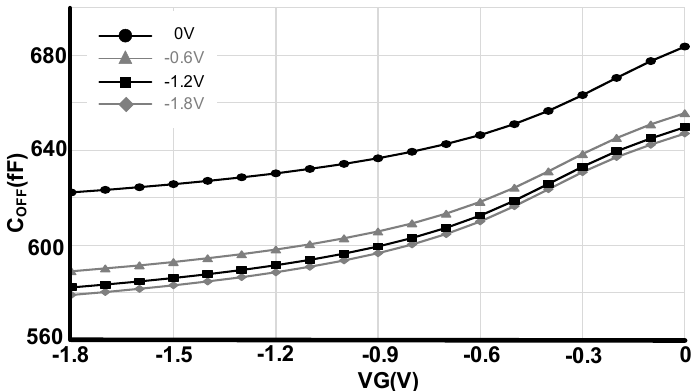
Figure 4. C OFF for different gate and body